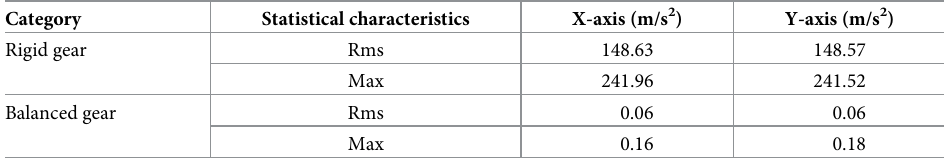
Table 7. Comparison of vibration response of the old and new